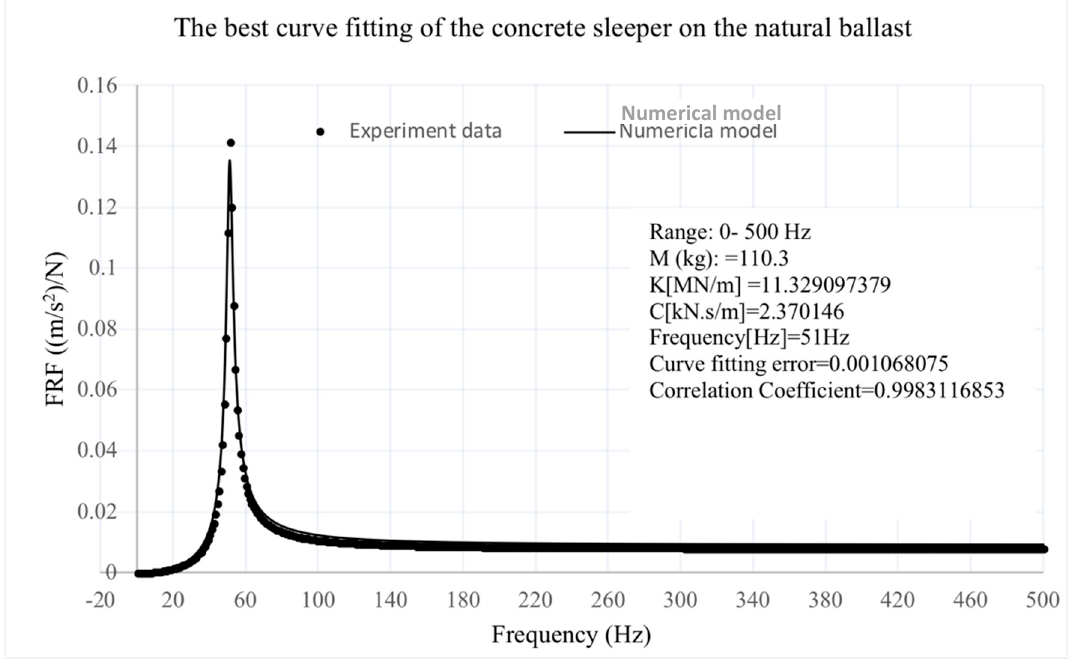
Figure 14. Curve fitting.